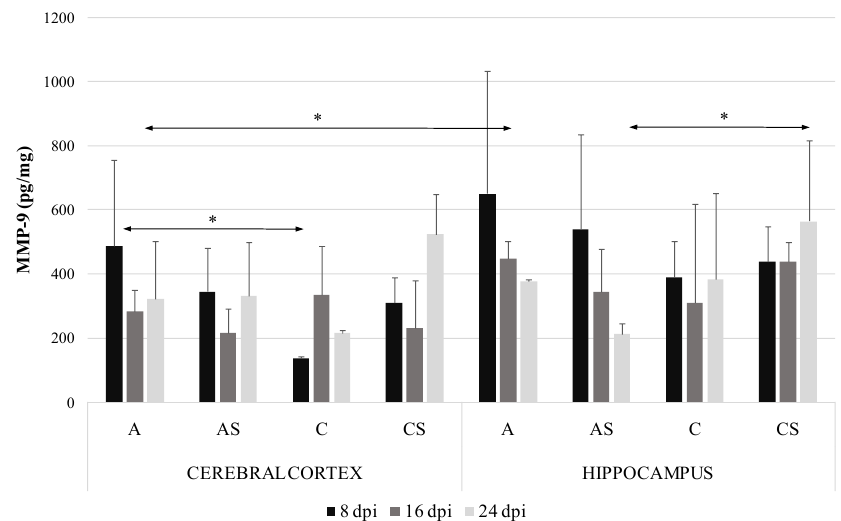
Figure 2. Matrix metalloproteinases-9 (MMP-9) level (pg/mg protein) in the cerebral cortex and hippocampus in control and infected groups at 8, 16 and 24 days post Acanthamoeba spp. infection (dpi). Data represent means ± SD for 6 independent experiments. C, immunocompetent uninfected control group mice; CS, immunosuppressed uninfected control group mice; A, immunocompetent Acanthamoeba spp. infected mice; AS, immunosuppressed Acanthamoeba spp. infected mice; * p ≤ 0.05 for the significance of difference (Mann–Whitney U test).